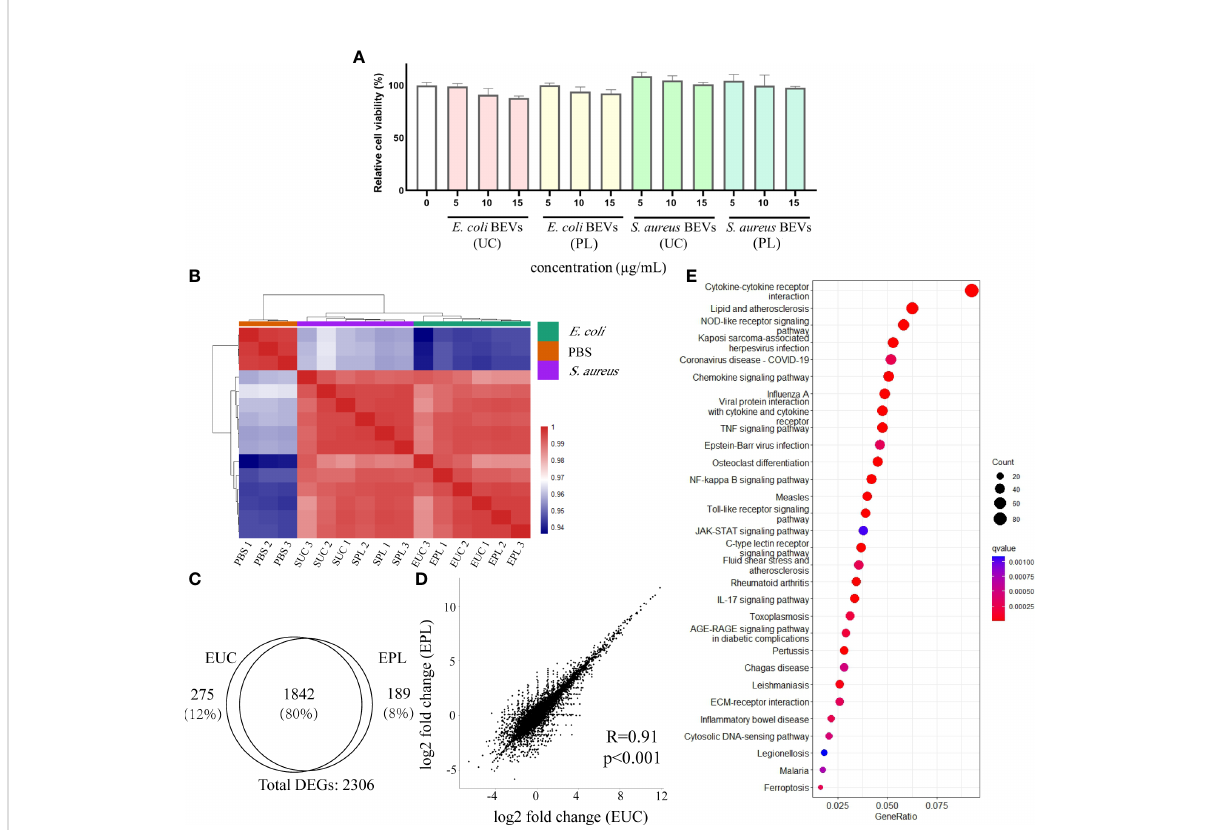
FIGURE 6 Transcriptional analysis of THP-1 cells stimulated with BEVs. (A) Calculated percentage cytotoxicity of cells (EUC, 1 m g/mL E. coli BEV isolated by UC; EPL, 1 m g/mL E. coli BEV isolated by PL; SUC, 10 m g/mL S. aureus BEV isolated by UC; SPL, 10 m g/mL S. aureus BEV isolated by PL). (B) The heat map was performed by using the Euclidean distance method with complete linkage for all samples (PBS1, PBS2, PBS3 are triplicates of non-stimulated THP-1 cells; EUC1-3 and EPL 1-3 are triplicates of cells stimulated with 1 m g/mL E. coli BEV isolated by UC and PL, respectively; SUC1-3 and SPL 1-3 are triplicates of cells stimulated with 10 m g/mL S. aureus BEV isolated by UC and PL, respectively). (C) Venn diagram of genes that are differentially expressed compared to non-stimulated cells in EUC and EPL group. (D) Correlation analysis of DEGs identi fi ed in EUC and EPL group. (E) Enrichment analysis of KEGG pathways enriched for overlapping DEGs in EUC and EPL group. Top 30 enriched KEGG pathways were selected for